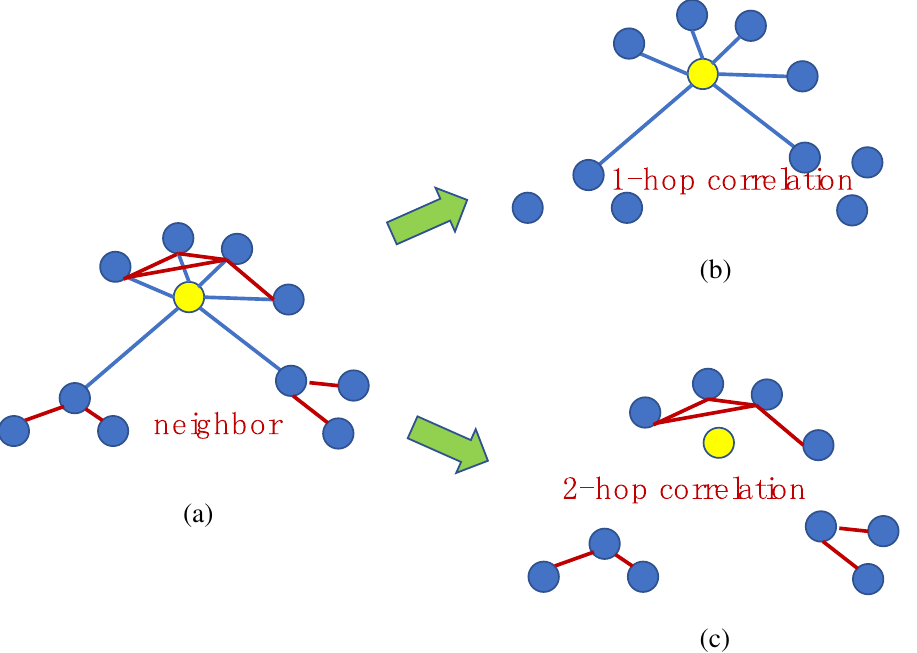
Figure 4. Five-layer MSM structures. The 1-hop and 2-hop neighbors of a feature are dotted in ( a ), and the 1-hop and 2-hop associations in ( c ) are given in ( b ) under the same spatial position, such that the correlation of all features can be fully connected. In the figure, the blue line is a 1-hop connection, and the red line is a 2-hop